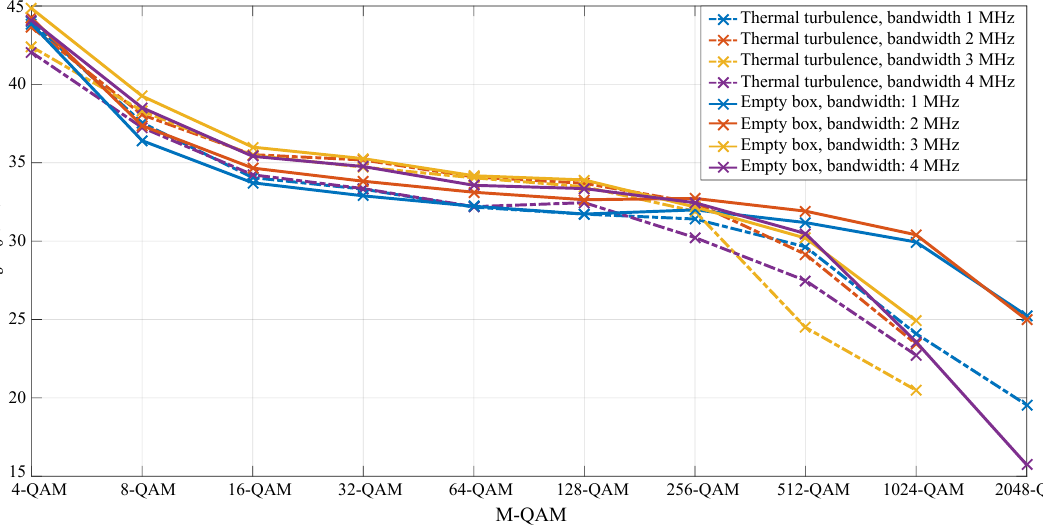
Figure 20. E b /N 0 /distance relationship for Octavia tail-light with different M-QAM and bandwidths—scenario 2—thermal